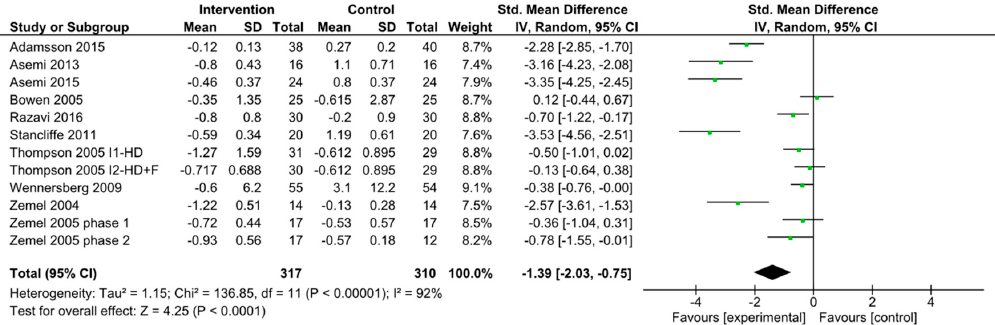
Figure 3. Forest plot of randomized clinical trials of dairy intake and HOMA-IR with BMI > 25. Abbreviations: F, fiber; HD, high dairy diet.